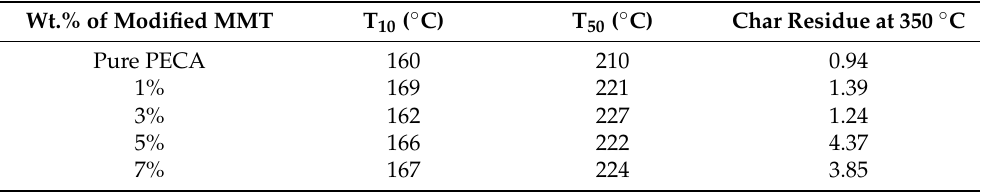
Table 4. Thermal properties of pure PECA and PECA–modified Mt composites with different Wt.% [79].